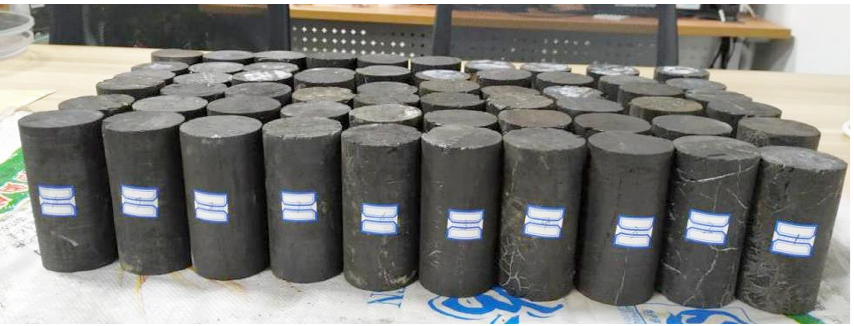
Figure 3. The standard raw coal samples.